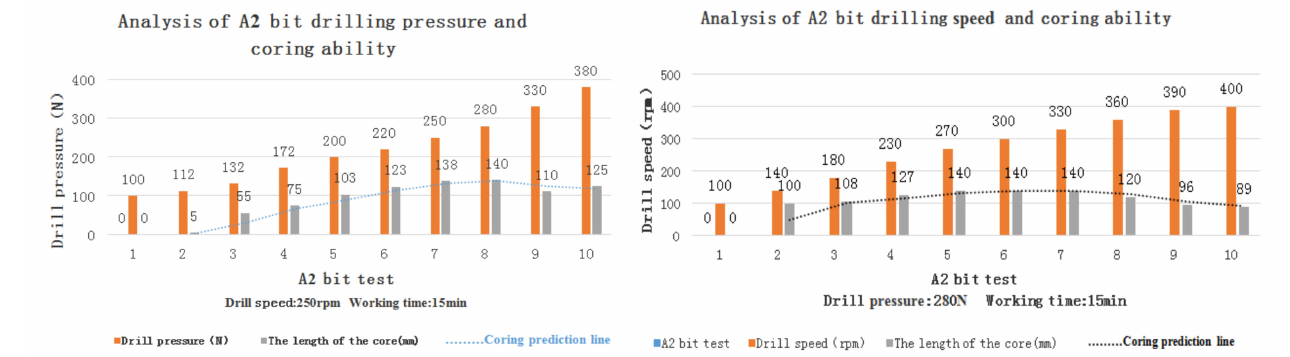
Figure 12. Prediction and analysis of drilling pressure, rotary speed and coring ability parameter curve of A2